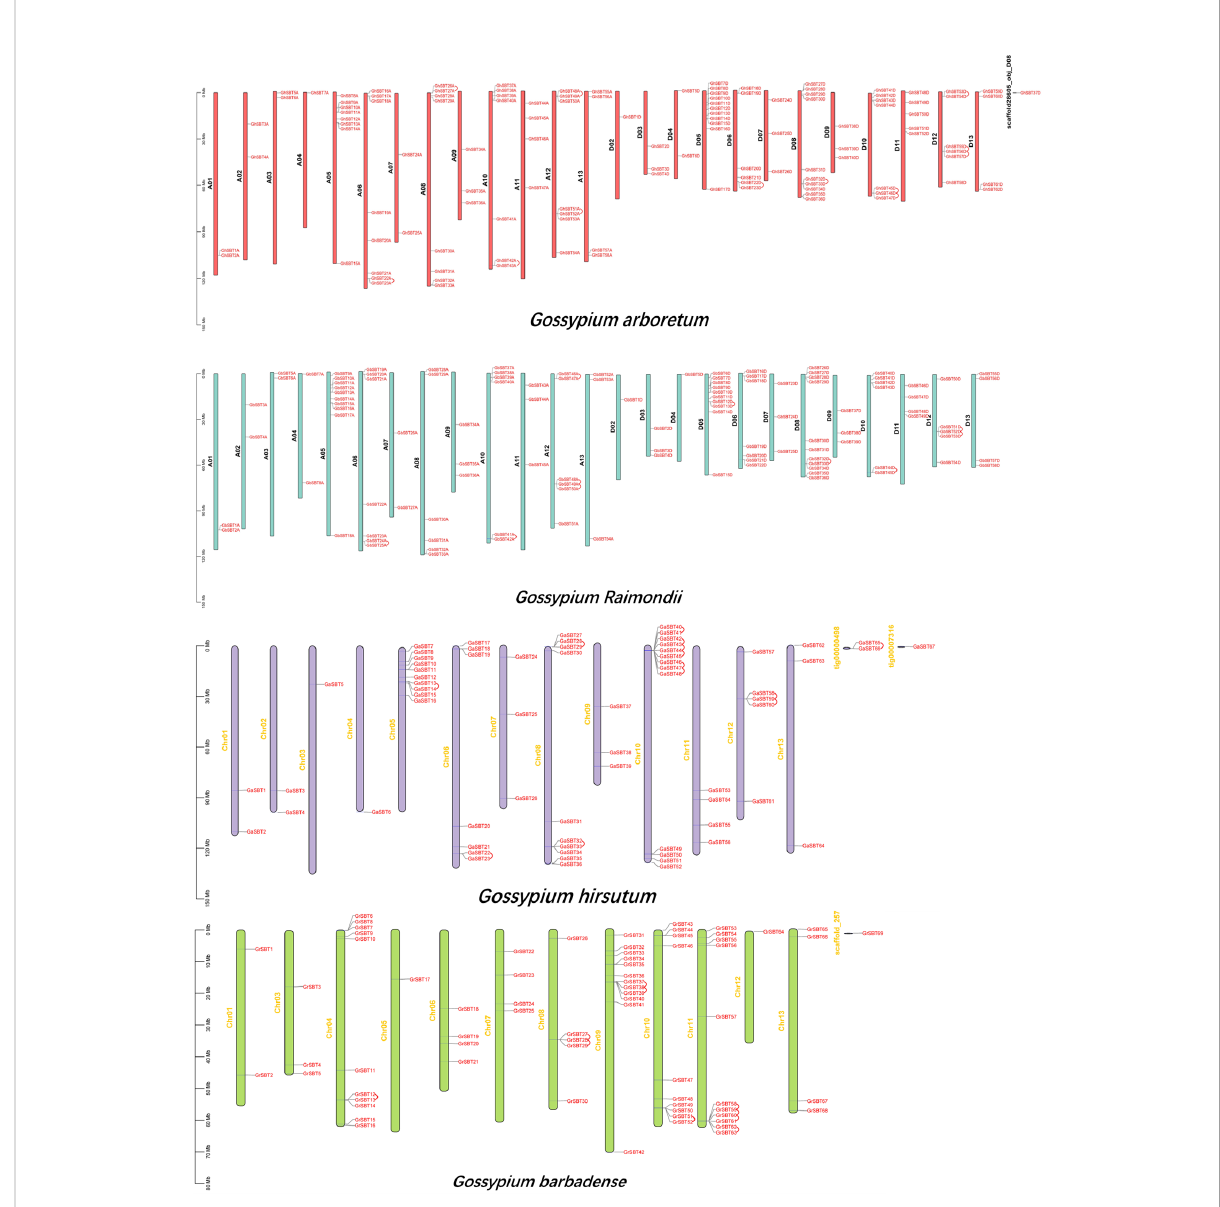
FIGURE 2 Chromosomal localization and gene duplication of SBT genes in Gossypium arboretum , Gossypium raimondii , Gossypium hirsutum , and Gossypium barbadense , and tandem duplication of gene pairs during evolution is shown by